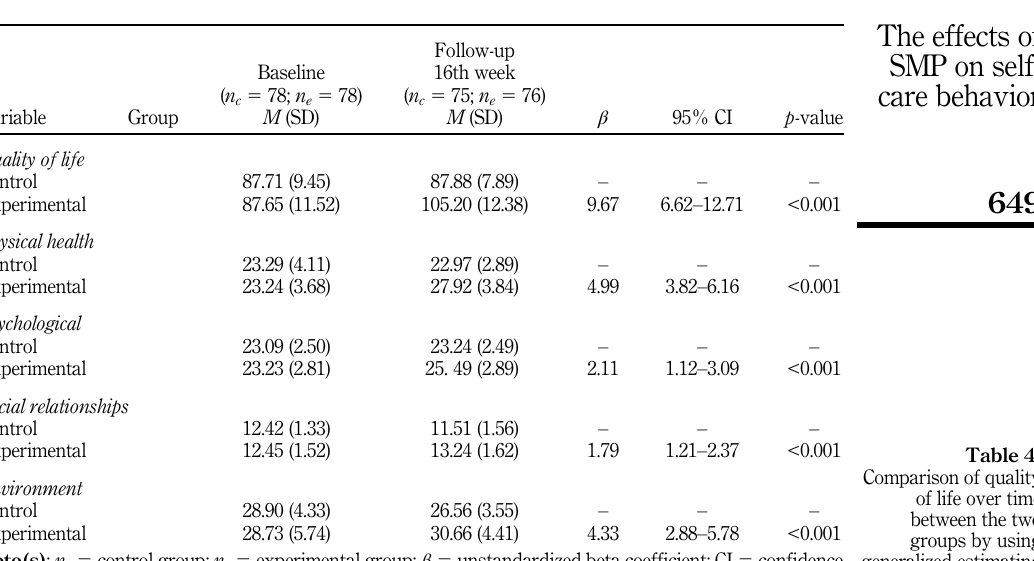
Table 4. Comparison of